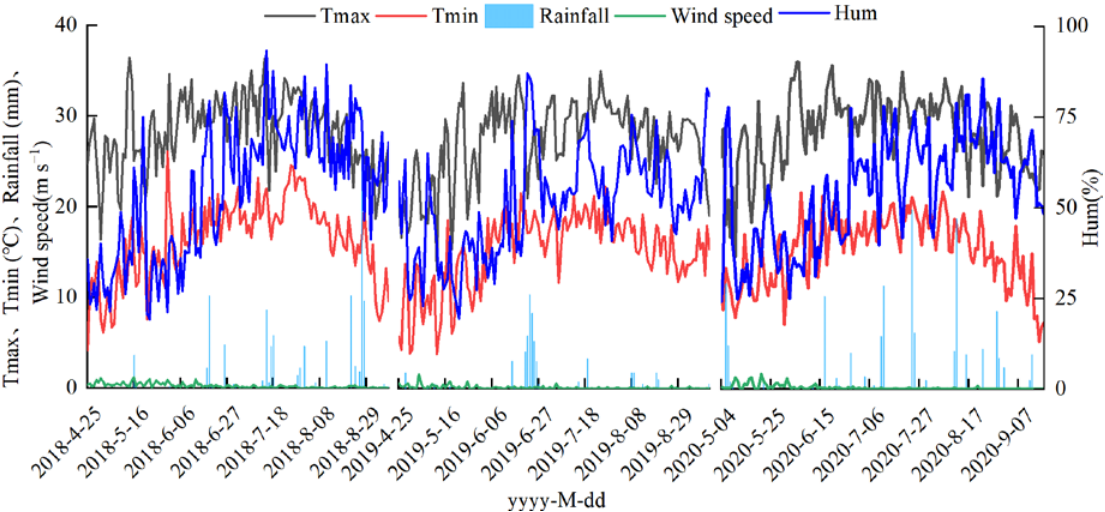
Figure 1. Daily air temperature, precipitation, wind speed, and humidity from 2018 to 2020.